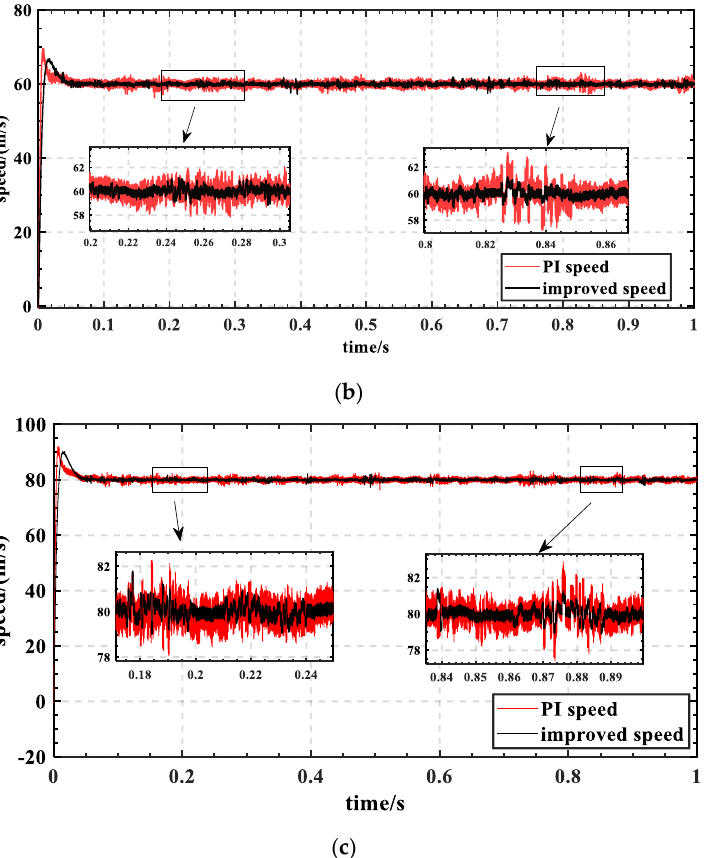
Figure 15. Comparison of operation speed of two control systems at different given speed states: ( a )